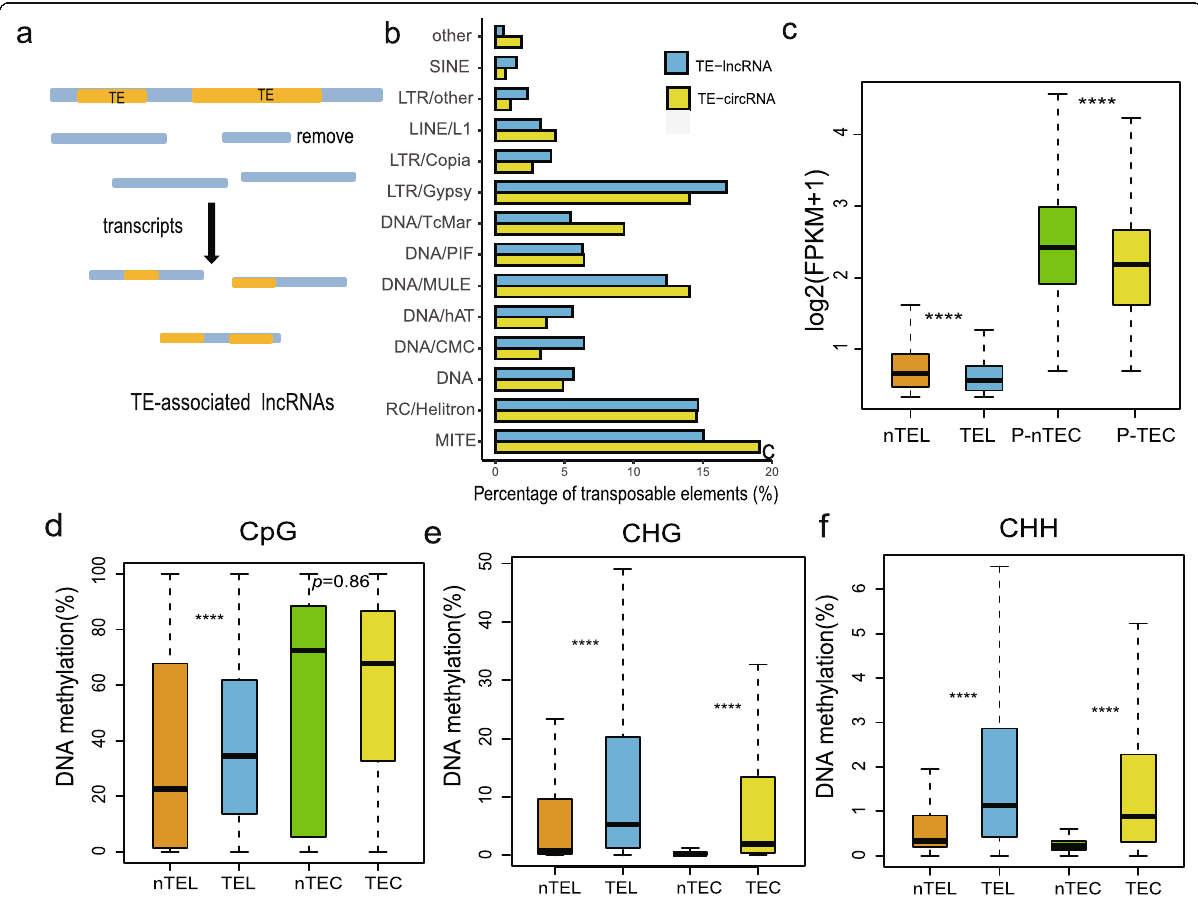
Fig. 3 Transposable elements associated with lncRNAs and circRNAs in MH63. a Representation of TE-associated lncRNAs. b Distribution of TEs of the TE-associated lncRNAs and circRNAs. c Comparison of the expression (FPKM) in TE-associated (TEL) and non-TE-associated (nTEL) lncRNAs, and in the parental genes of TE-associated (P-TEC) and non-TE-associated (P-nTEC) circRNAs. Comparison of ( d ) CG, ( e ) CHG and ( f ) CHH DNA methylations between TE-associated and non-TE-associated lncRNAs (TEL, nTEL) and circRNAs (nTEC, TEC),